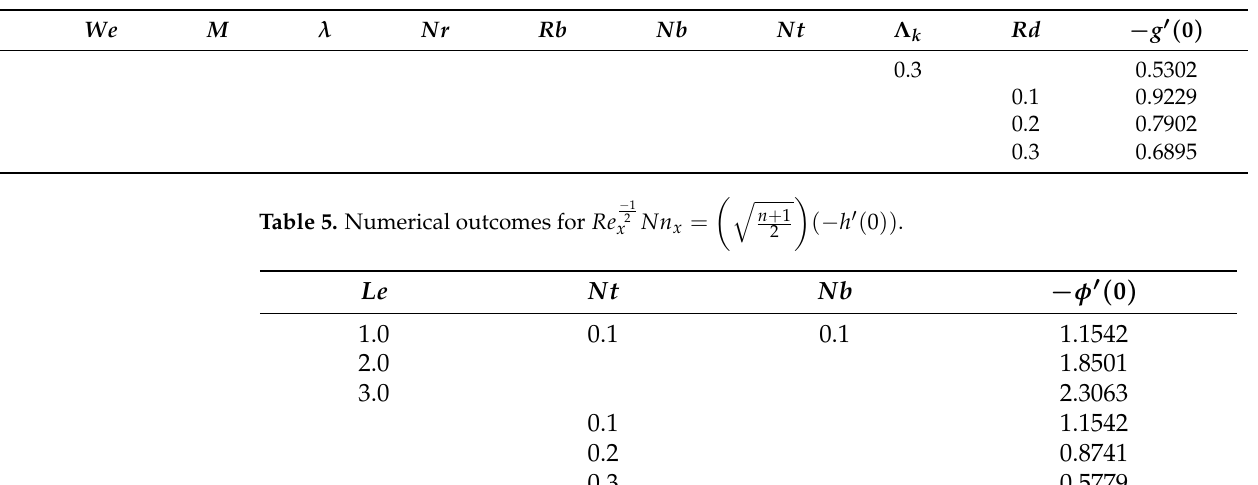
(cid:18)(cid:113) (cid:19) n + 1 ( − ζ (cid:48) ( 0 )) 2